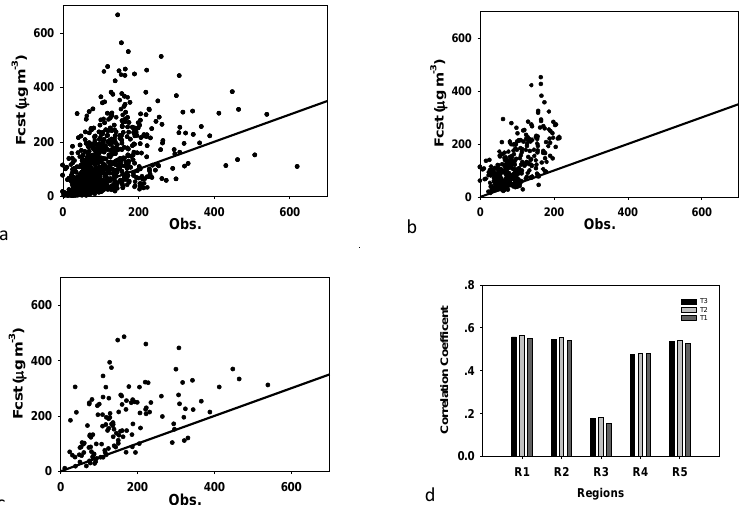
Figure 8. Panels (a) , (b) , and (c) display scatter plots of daily average PM 2 . 5 between the model and the observations for T3 in R1, R4, and R5. Panel (d) depicts correlation coefficients of PM 2 . 5 between the simulation and measurements for T1, T2, and T3 in the regions of R1, R2, R3, R4, and R5. Fcst denotes